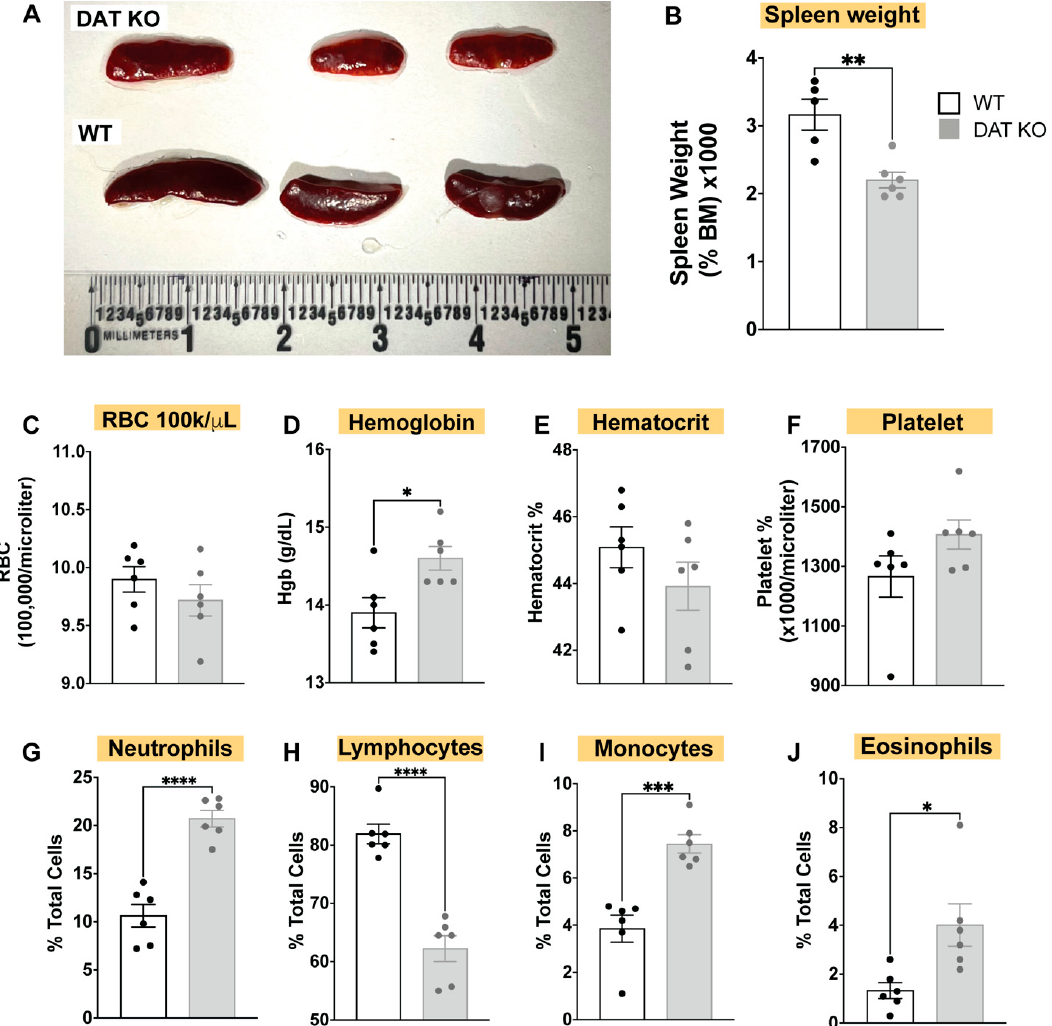
Figure 1. DAT − / − mice exhibit spleen hypoplasia and reduced weight and exhibit altered peripheral immune populations via CBC. ( A ) Qualitative assessment of spleen size and appearance indicates DAT − / − animals show spleen hypoplasia, and splenic pallor, suggesting that DAT − / − mice may exhibit immune dysfunction or anemia, with ( B ) spleen weight taken as a fraction of total body weight confirming reduced spleen size ( n = 5 WT, n = 6 DAT − / − ). Contrary to qualitative splenic pallor, via complete blood count with differential (CBC-diff) from DAT − / − mice and WT controls we found that ( C – F ) DAT − / − mice do not show reduced RBCs, hemoglobin, hematocrit, or platelet density (CBC). However, differential results from CBC-diff shows perturbed WBC populations in DAT − / − mice relative to control, showing increased myeloid lineage cells (neutrophils, monocytes, and eosinophils); ( G , I , J ) alongside decreased total lymphocytes ( H ). (Unpaired two-tailed t -test, with Holm–Sidak correction for multiple comparisons; n = 6/group; * p < 0.05, ** p < 0.01, *** p < 0.001, **** p < 0.0001).